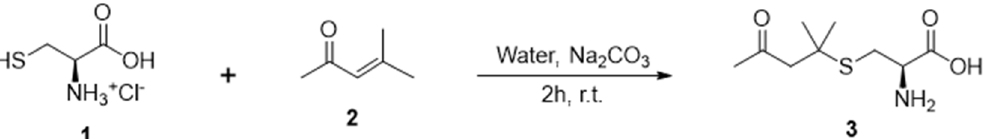
Figure 1. Mass spectrum of synthetic cysteine monoadduct 3 (cys-4MMP).